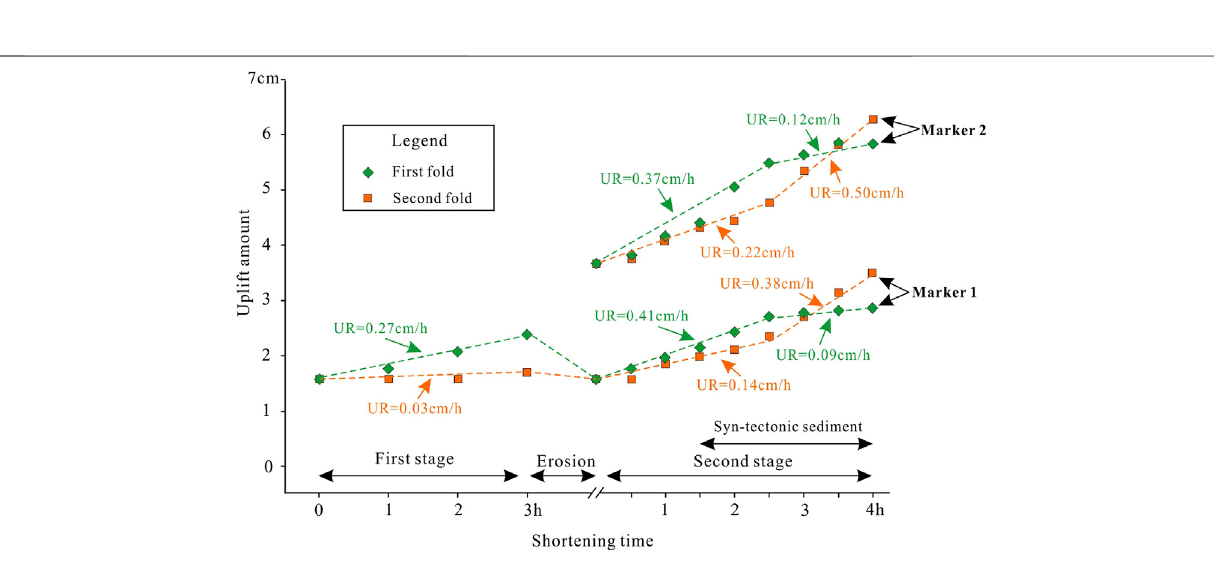
Frontiers in Earth Science |